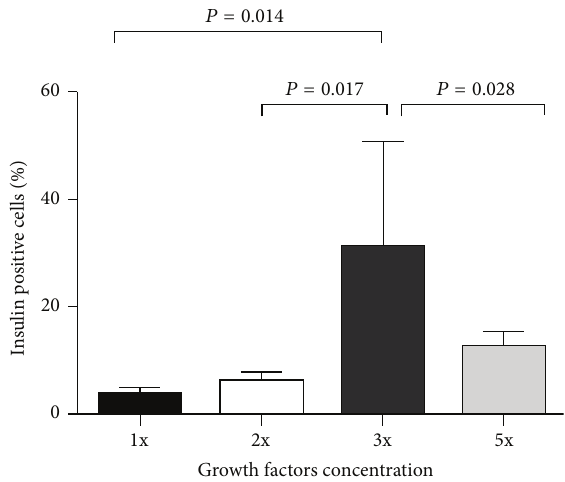
Figure 2: The influence of growth factors’ concentration in a growth medium on the number of differentiated IPCs. The largest expression of C-peptide in IPCs was found at concentration of growth factors increased 3 times. An increase in growth factors’ concentration above this threshold does not increase the degree of